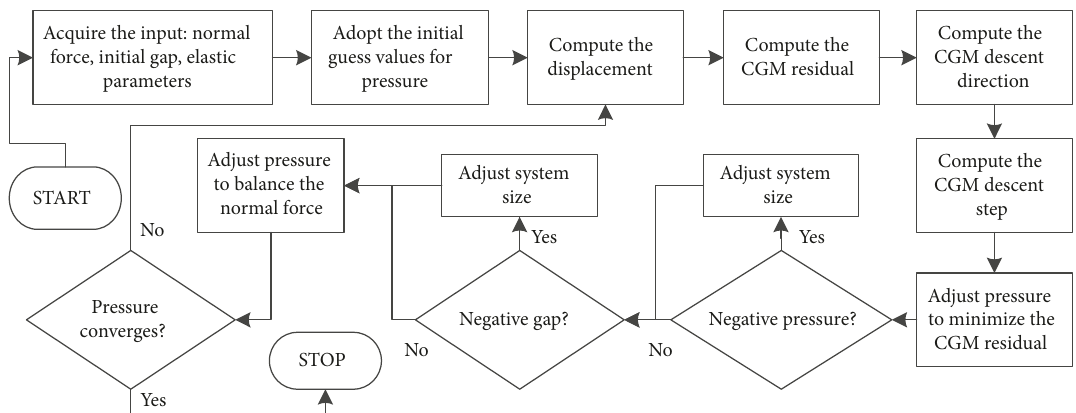
Figure 2: Algorithm flowchart for the frictionless contact problem of coated